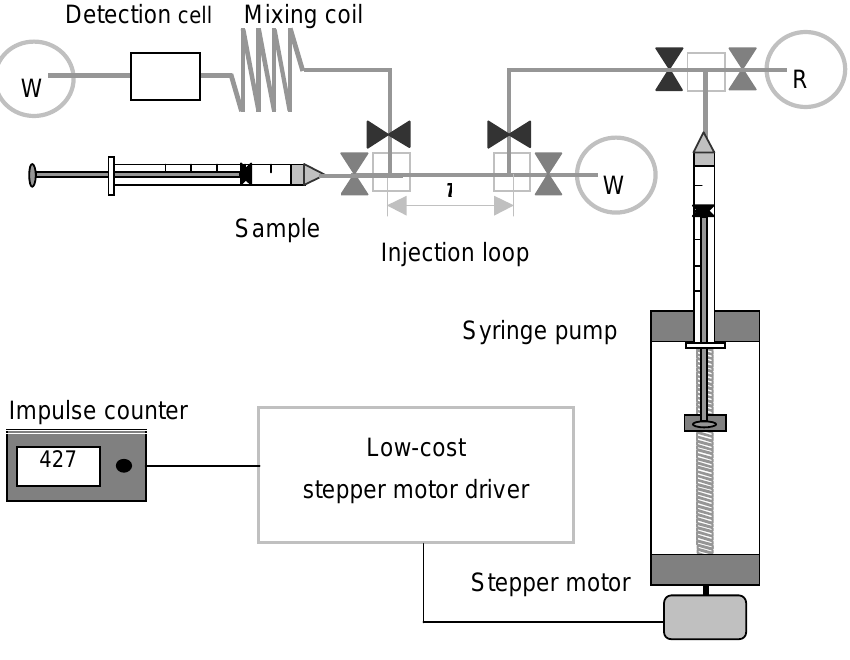
Figure 7. The low-cost simplified FIA set-up with volume-based injection, the assembling of which we suggest for low-budget circumstances and which we used for testing the proposed spectrometric detector for real-life applications in the green light range. We used this set-up together with a low-cost data-acquisition device with a data-point sampling rate limited to 1 measurement per